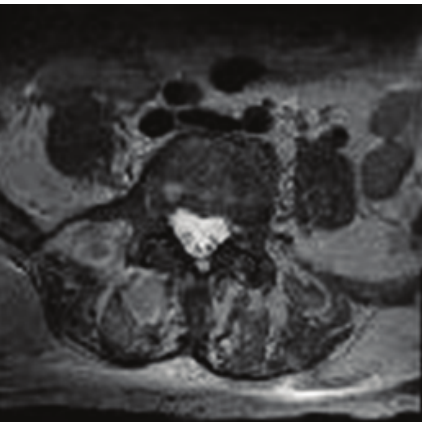
Figure 1: MRI: axial thoracolumbar spine T2.